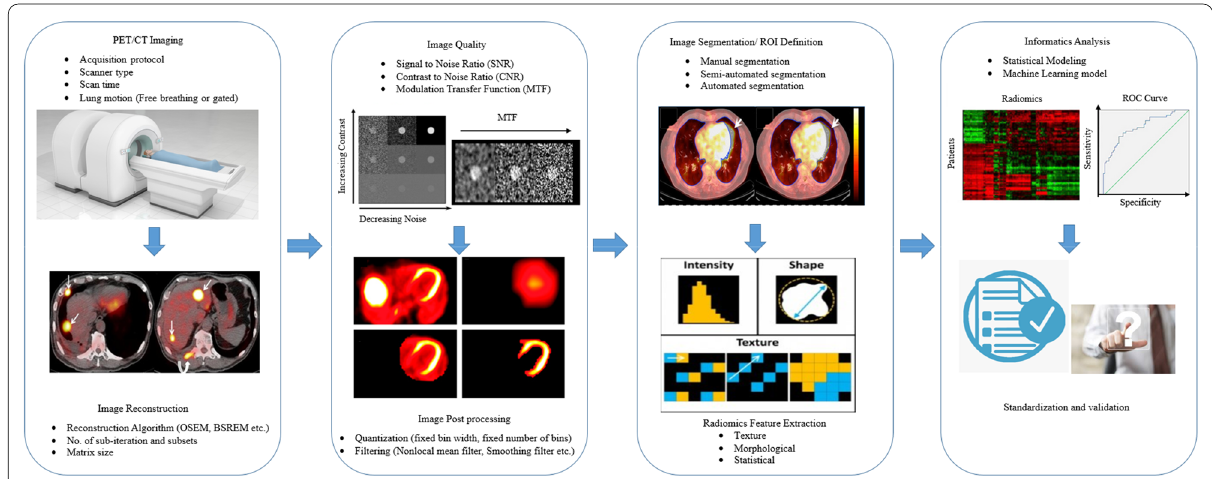
Fig. 2 Workflow of radiomics texture